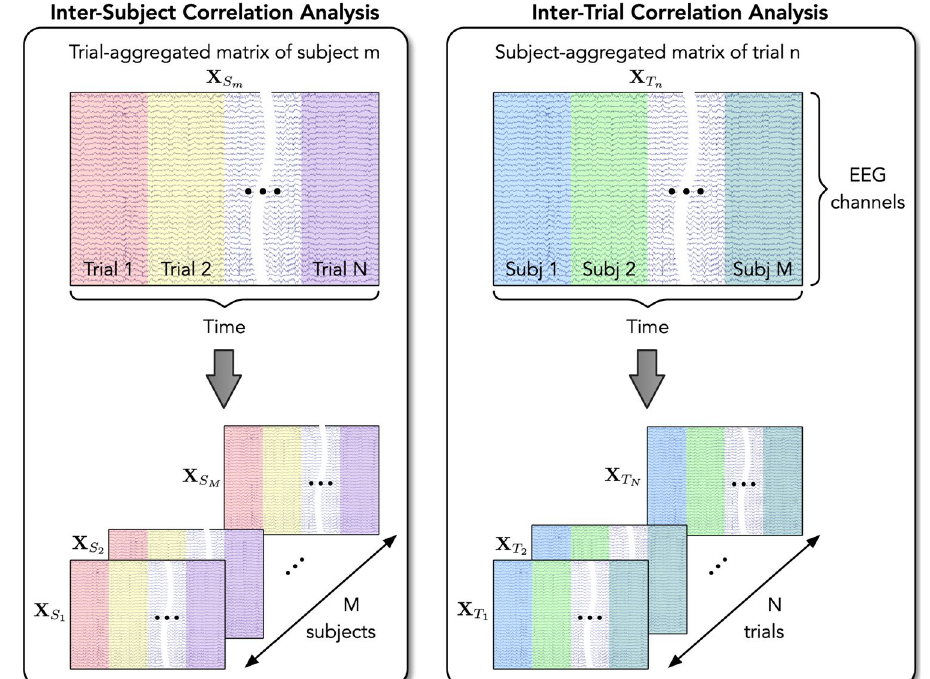
Figure 3. Illustration of the EEG data generation for the ISC and ITC